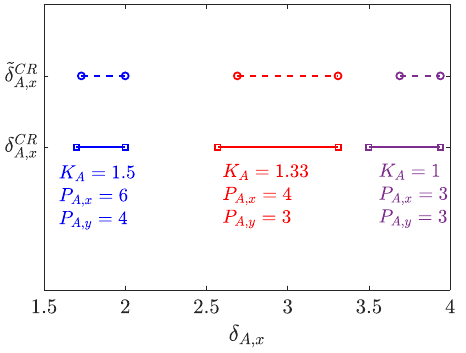
Figure 13. True range of δ CR versus predicted range ˜ δ CR A , x Φ typ = 270 lm, Φ = π , ζ t x = ζ t y = 0.8, P L = 20 LEDs and for different K A v 1/2 3